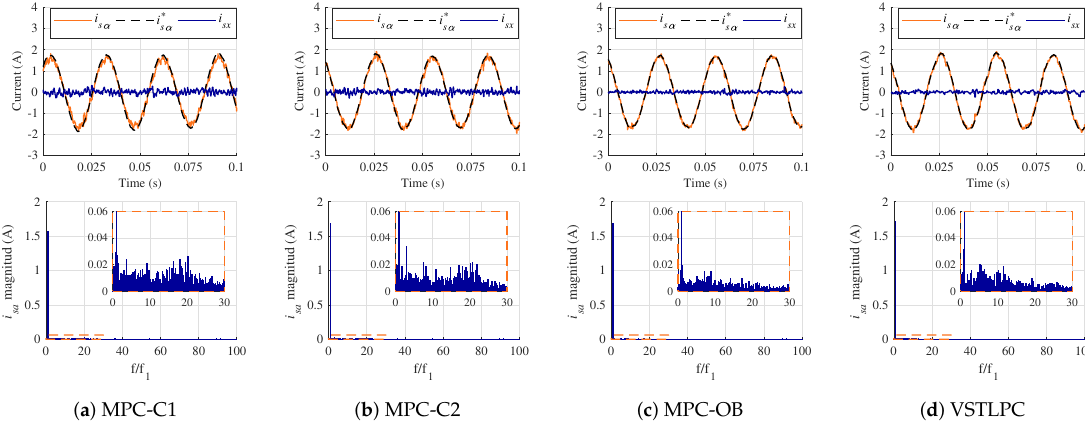
Figure 5. Experimental steady-state test for 600 rpm and a load torque of 70% of the nominal one. Upper plots present the α and x current trajectories, and the lower plots present the a -current